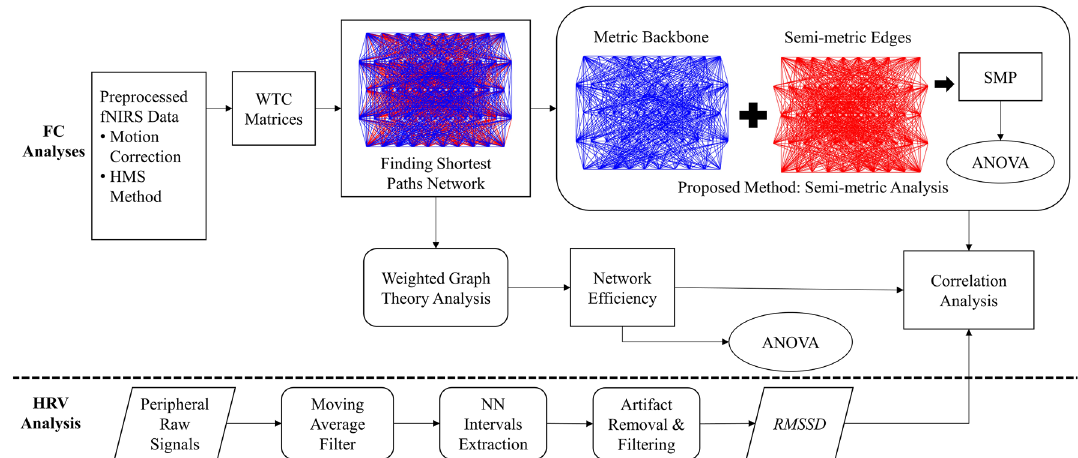
Figure 3. Summary flow chart for FC analyses and HRV analysis. Using the weighted network theory, the derived shortest path was directly quantified into network efficiency. In semi-metric metric analysis, the semi- metric component was extracted to be quantified as SMP